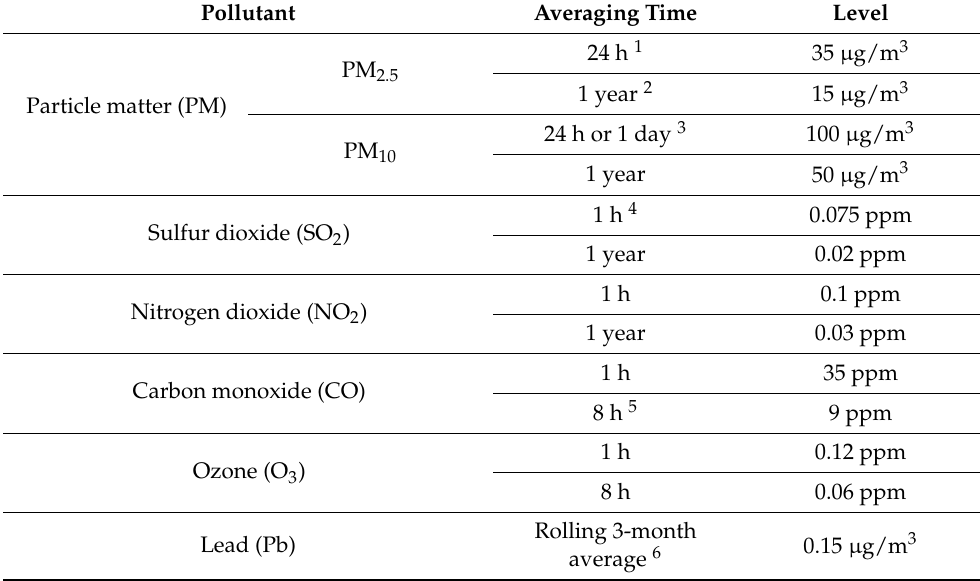
Table 1. Ambient air quality standards in